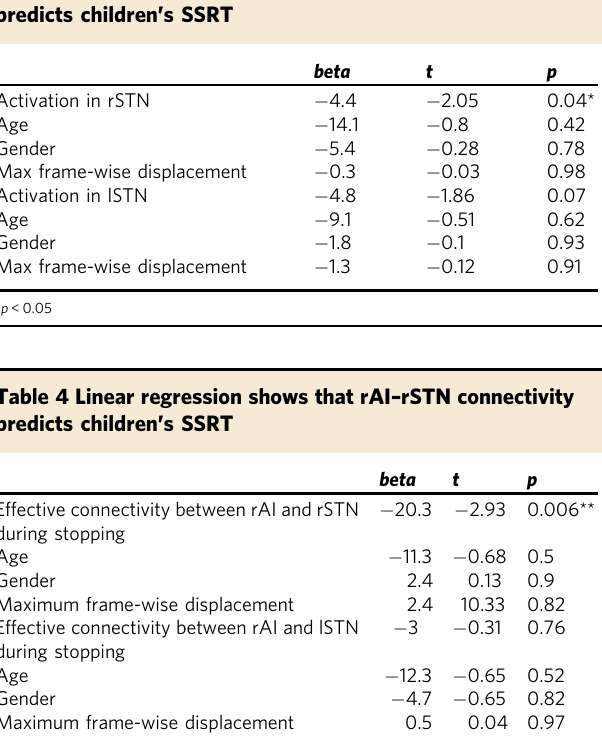
Third, we examined the relationship between rAI – rSTN effective connectivity and SSRT in the ABCD dataset. We found that stop signal-modulated effective connectivity between the rAI and rSTN, but not the lSTN, during stopping was signi fi cantly